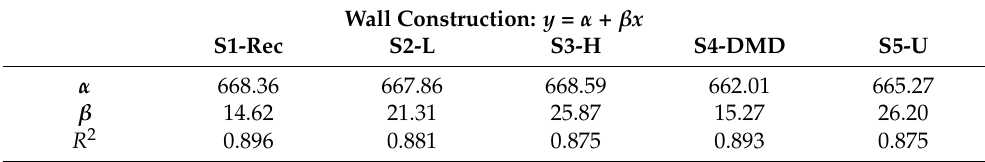
Table 7. Summary of wall construction regression equations.